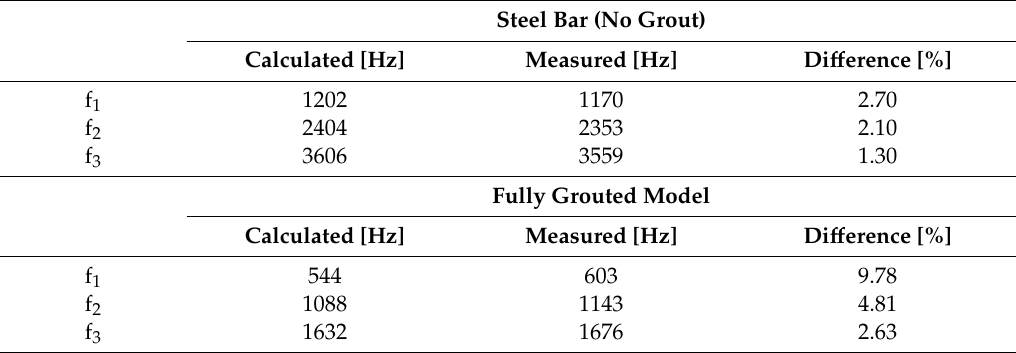
Table 1. Comparison of calculated and measured first three natural frequencies of steel bar and fully grouted model. Steel Bar (No Grout) Calculated [Hz] Measured [Hz] Di ff erence [%] f 1